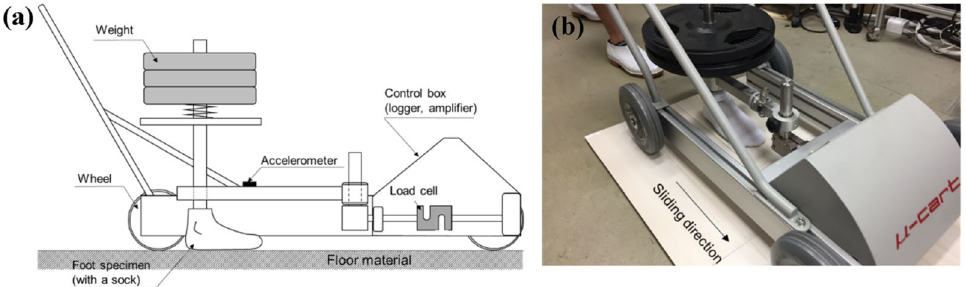
Figure 2. Cart-type friction measurement device. ( a ) Schematic of the cross-sectional view of the mechanical system configuration and ( b ) photo of friction